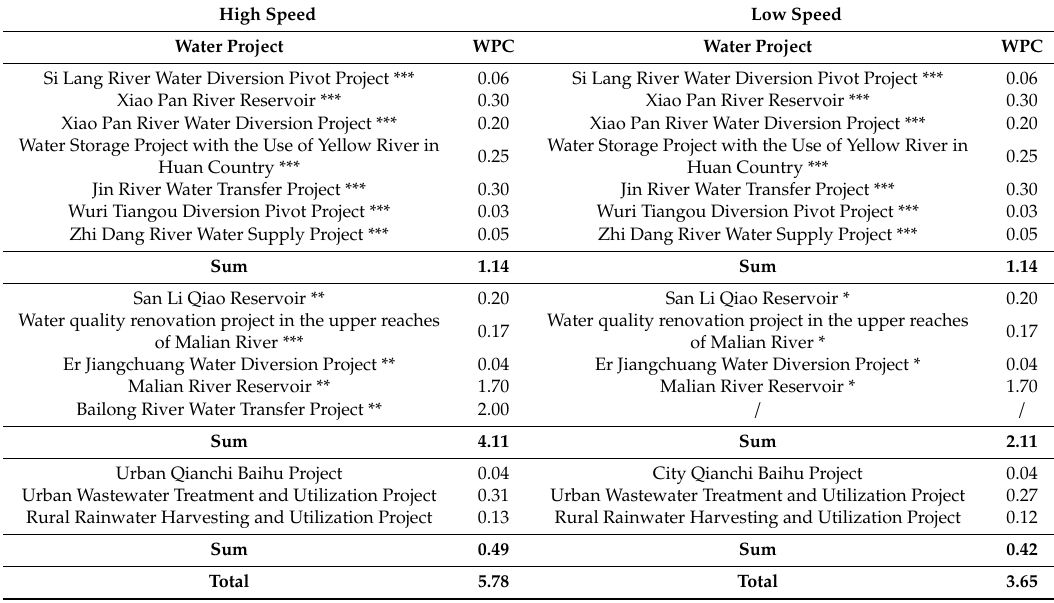
Table 3. Water supply forecast table in 2030. The water supple capacity (WPC, 10 8 m 3 ) in the table refers to increased water supply